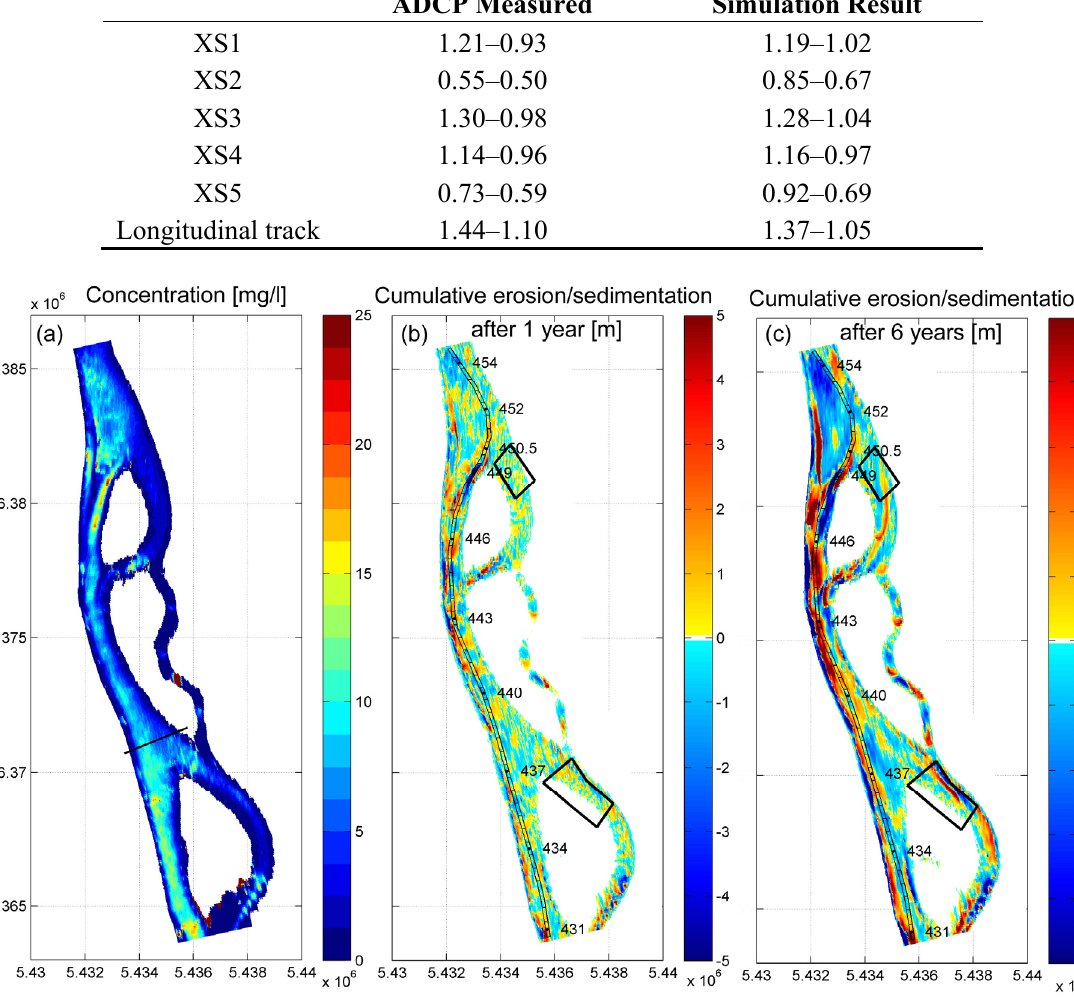
Figure 6. Simulated maps of ( a ) sediment concentration suspended from the riverbed with the indication of the investigated cross-section in 2010 during a flow condition of 14,300 m 3 /s; ( b ) simulated cumulative patterns of erosion-deposition after one year (from 2004 to 2005); ( c ) and after six years (from 2004 to